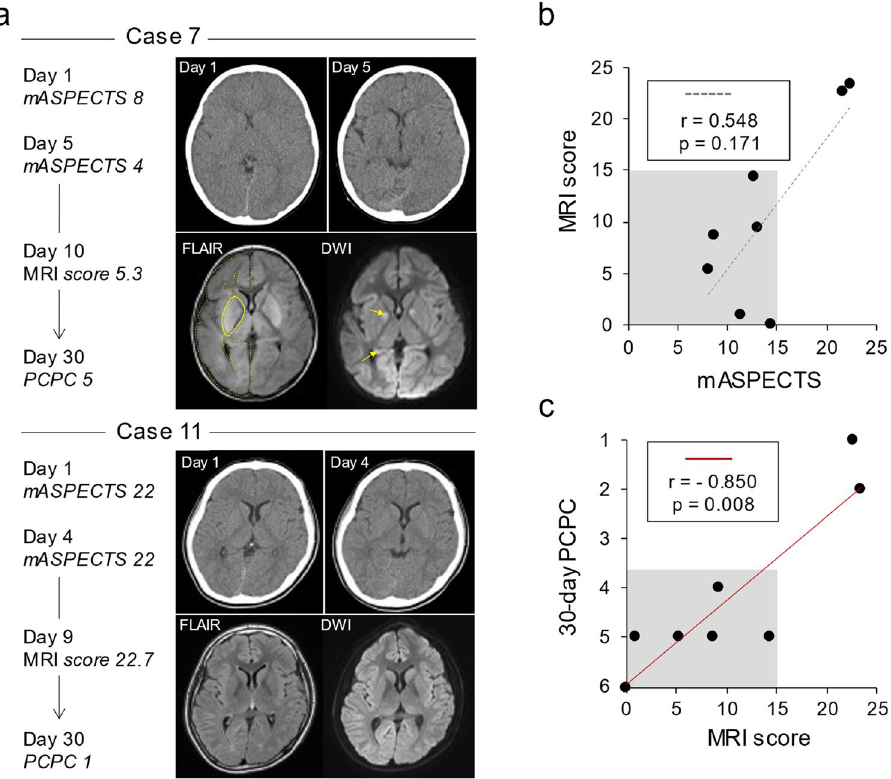
Figure 5. Follow-up MRI findings and neurological disabilities of the 30-day survivors. ( a ) Time courses of two representative cases with different mASPECTS and neurological outcomes. Note that Case 7 (upper) showed more severe brain damage and neurological disability at day 30 than Case 11 (lower). In the right panels, the first CT (left upper), second CT (right upper) and follow-up MRI (FLAIR and diffusion-weighted image, DWI) findings are shown. Yellow lines and arrows indicate the regions with abnormal signals on FLAIR imaging and DWI, respectively. Only the right hemispheres are marked for clarity. ( b ) Relationship between the